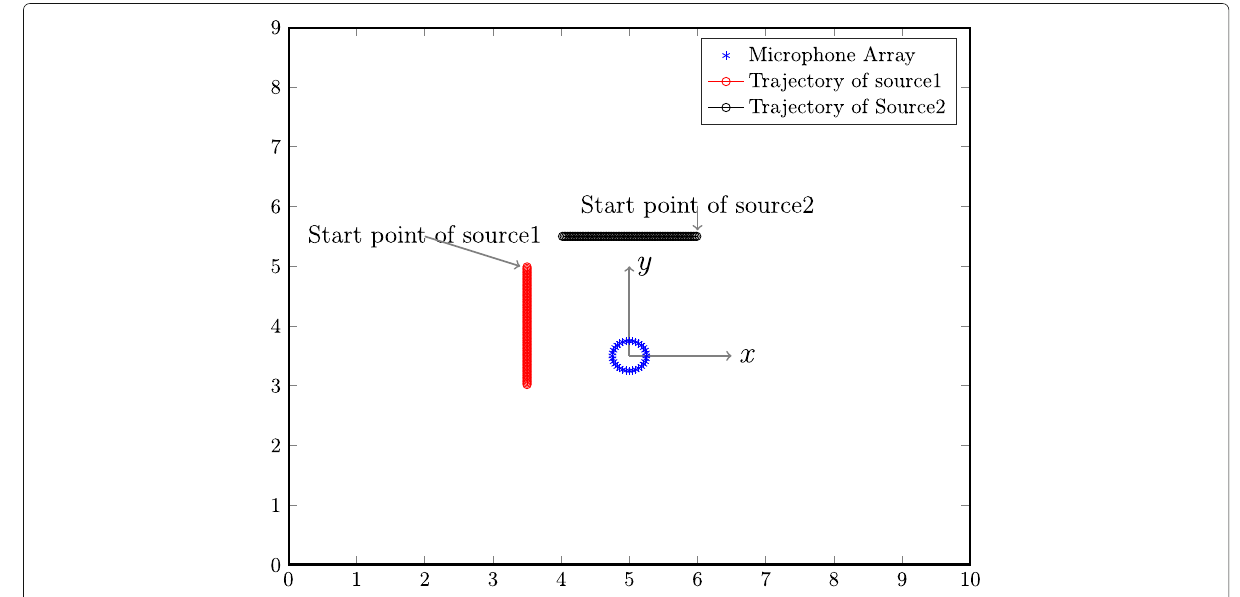
Fig. 6 Illustration of the first virtual room setup with two moving sources for the simulation